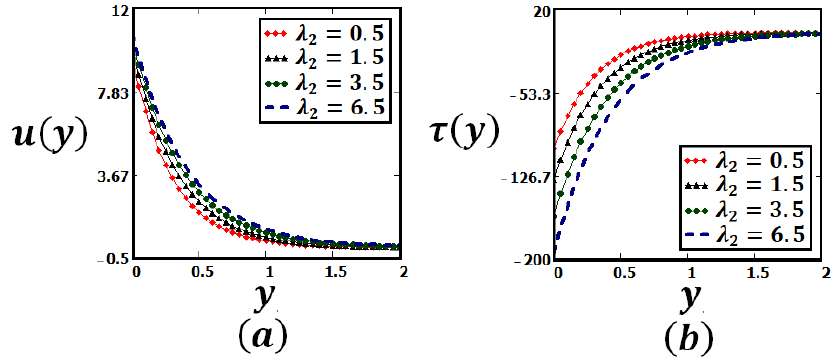
Figure 4: Profiles of the velocity field u ( y , t ) and the shear stress τ ( y , t ) for fractionalized Jeffrey fluid given by Eqs. (16) and (21), for A = 1, ν = 1.427, µ = 19, λ 1 = 9, H = 0.5, K = 2, α = 0.5, θ = 0.2, p = 4, t = 2 s and different values of λ 2 .